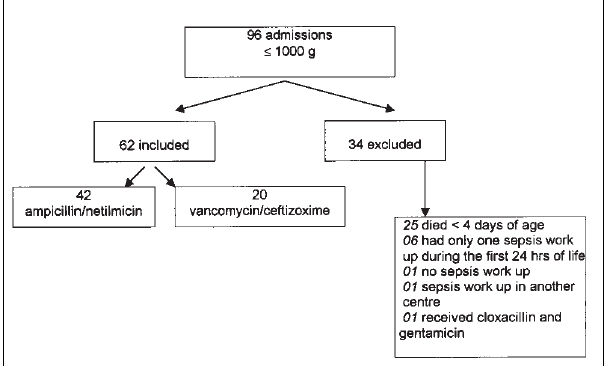
Figure 1 ) Flow diagram of study patients